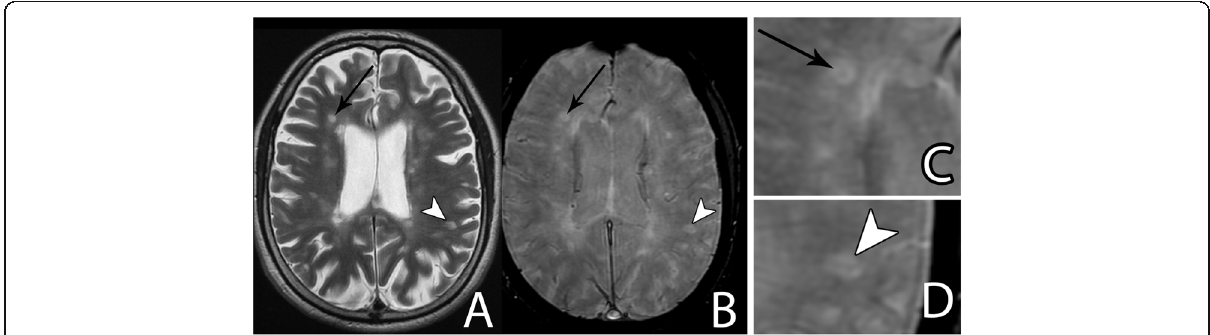
Fig. 5 Axial ( a ) T2WI image shows hyperintense MS periventricular and juxta-cortical lesions (arrow and arrowhead). On the corresponding SWI ( b ) and amplified SWI images ( c and d ), a thin hypointense line and a central hypointense dot (representing the CVS) are seen in the juxta- cortical (arrow head) and periventricular lesions (arrow),